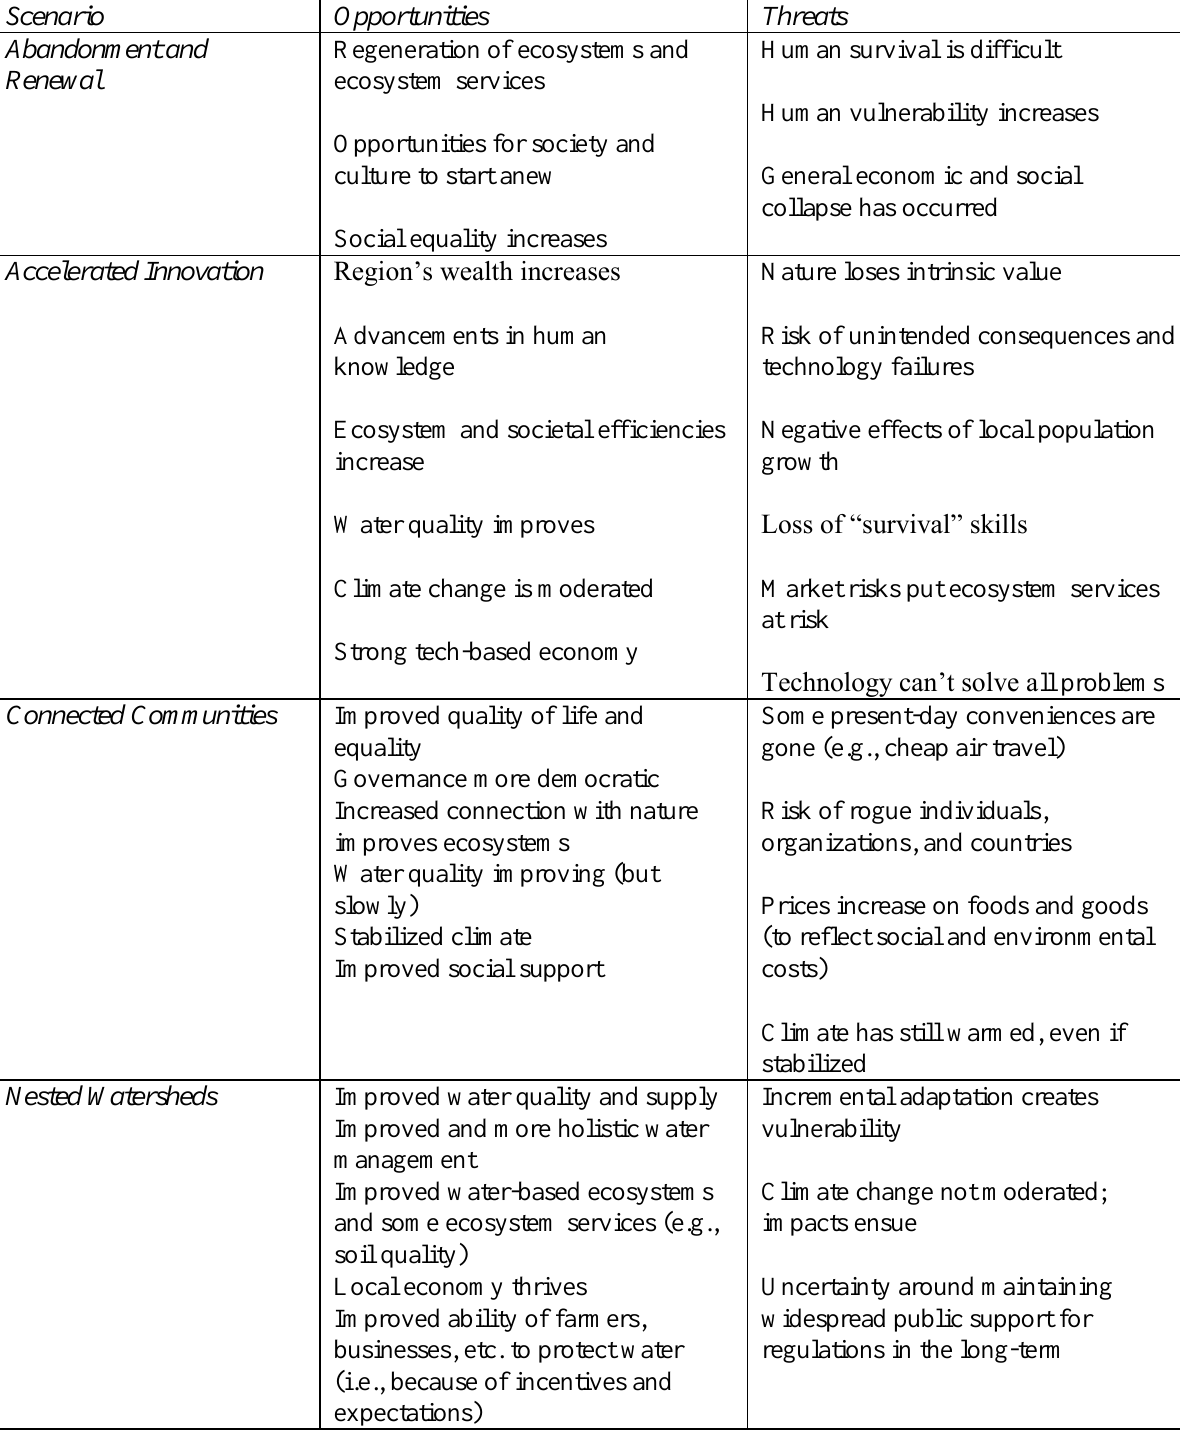
Table A1.4. Some opportunities and threats in each scenario